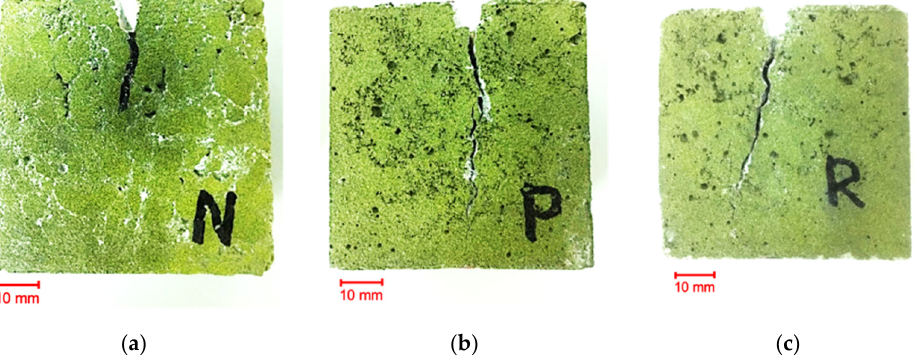
Figure 20. Pictures were taken with a digital camera illustrating the scratches formed in the sam- ples as a result of the WSP test: ( a ) NC), ( b ) SFRC and ( c ) RSFRC.